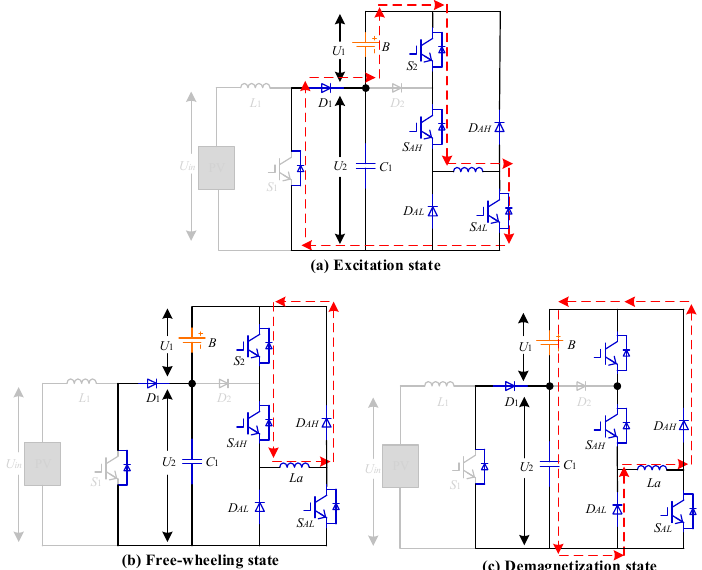
Figure 8. Working states of mode 2. ( a ) Excitation state. ( b ) Free-wheeling state. ( c ) Demagnetization state.